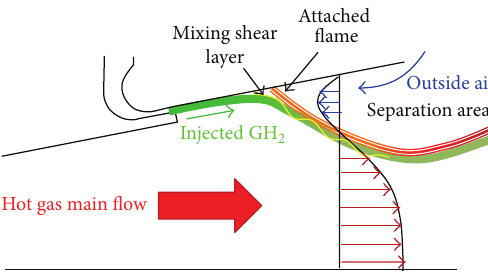
Figure 9: Flow configuration as deduced from CFD